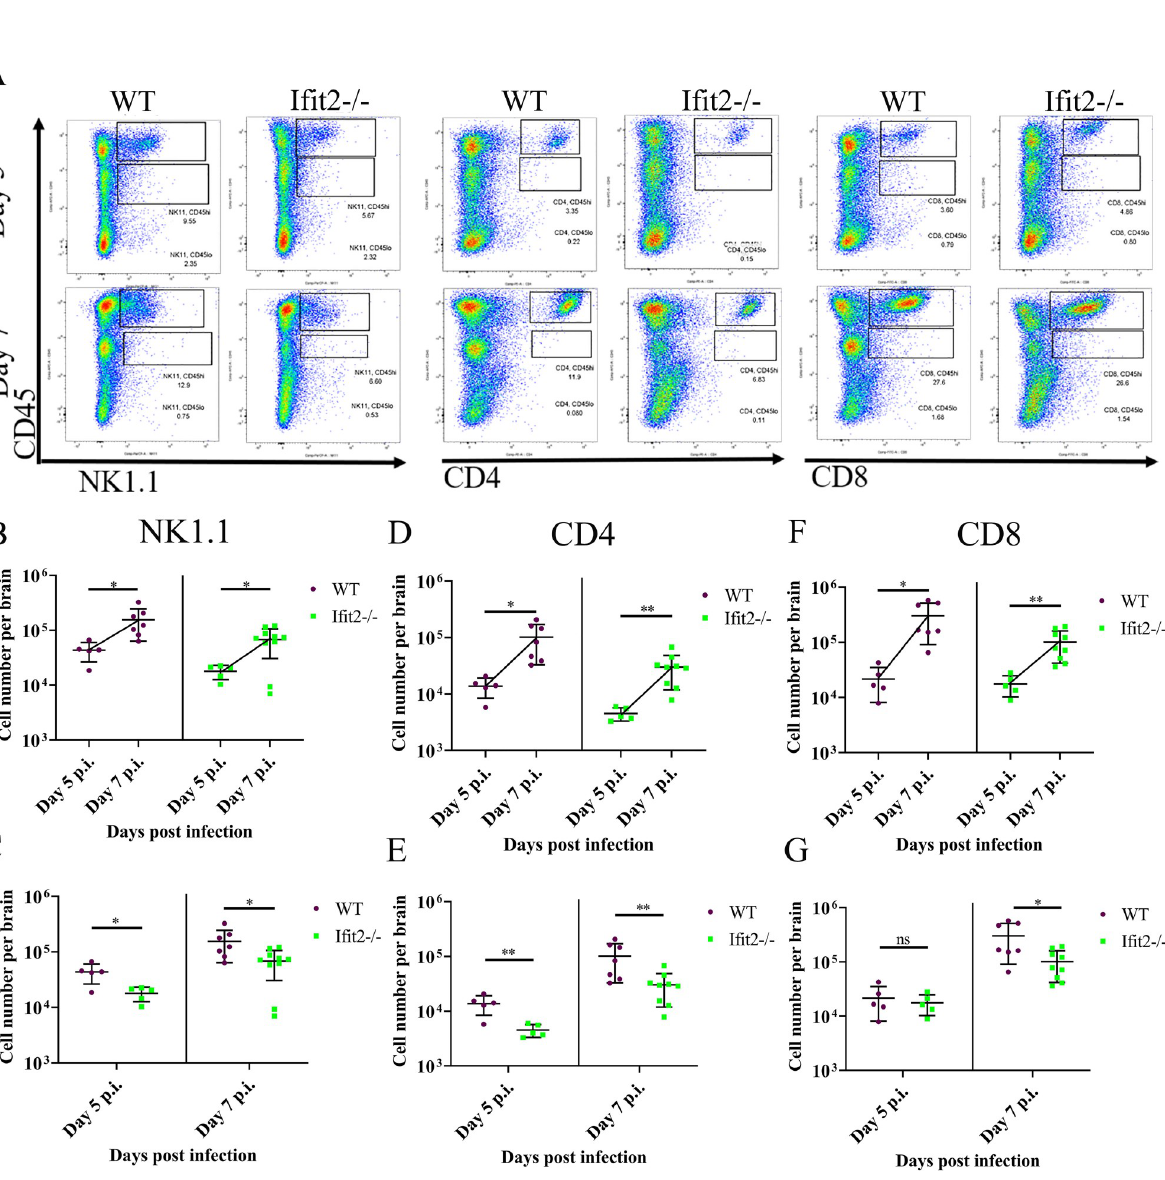
Fig 9. Ifit2 deficiency significantly impairs migration of NK1.1, CD4 and CD8 T cells among the CD45 hi population at acute stage of RSA59 infection. Dot Plot representation of the percentage of NK1.1, CD4 and CD8 expressing cells were gated from CD45 hi populations in the brain lysates, which was gated on live cells for both day 5 and 7 p.i. (Panel A). Purple colour denotes WT and green colour denotes Ifit2 -/- mice. Absolute number of NK1.1 expressing cells gated from CD45 hi population for both the WT and Ifit2 -/- total brain lysate is comparatively represented across timepoints (day 5 and day 7) (Panel B) and also between WT and Ifit2 -/- mice for day 5 p.i., and day 7 p.i. (Panel C). Absolute number of CD4 expressing cells gated from CD45 hi population for both the WT and Ifit2 -/- total brain lysate is comparatively represented across timepoints (day 5 and day 7) (Panel D) and also between WT and Ifit2 -/- mice for day 5 p.i., and day 7 p.i. (Panel E). Absolute number of CD8 expressing cells gated from CD45 hi population for both the WT and Ifit2 -/- total brain lysate is comparatively represented across timepoints (day 5 and day 7) (Panel F) and also between WT and Ifit2 -/- mice for day 5 p.i., and day 7 p.i. (Panel G). The data were pooled from two independent experiments with n = 5–10. Asterix ( � ) represents differences that are statistically significant by Student’s unpaired t-test analysis. ( � P < 0.05, �� P <